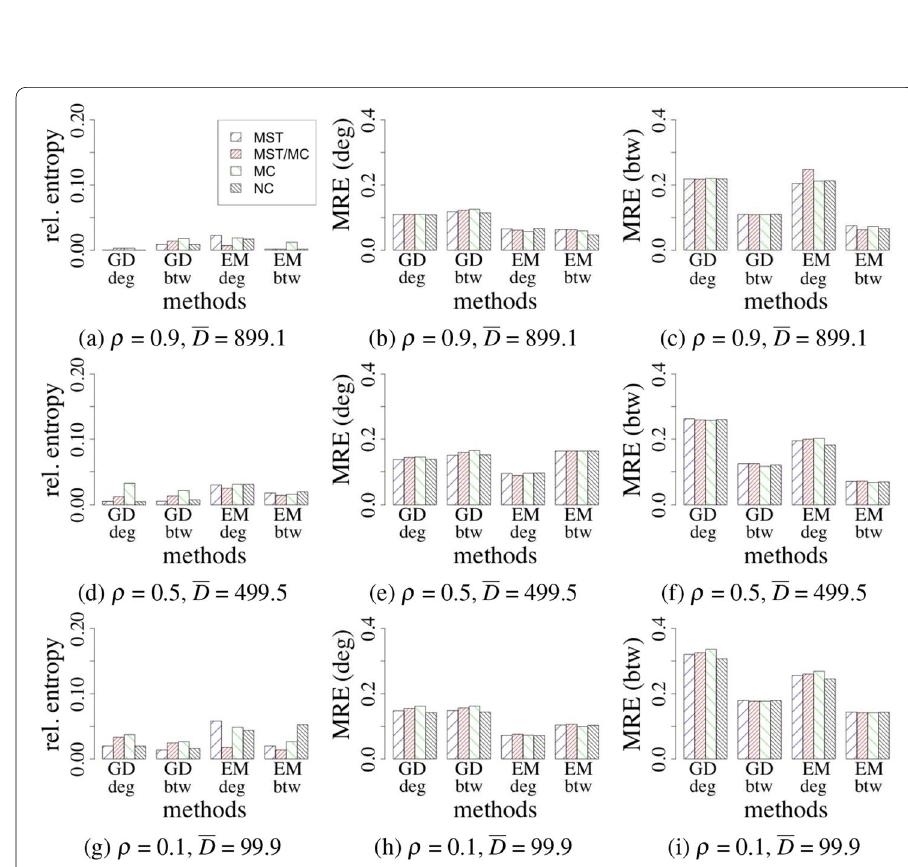
Fig. 5 Impact of density and backboning methods on sparsification - synthetic data: Relative entropy (column one), mean relative error of expected degree (column two) and mean relative error of expected ego betweenness (column three) of sparsified Erdős–Rényi graphs of different density and average degree. The results compare different sparsification methods over various backboning methods. In all graphs sparsification ratio is α = 0.45 . In MST/MC backboning method α ′ = 0.5